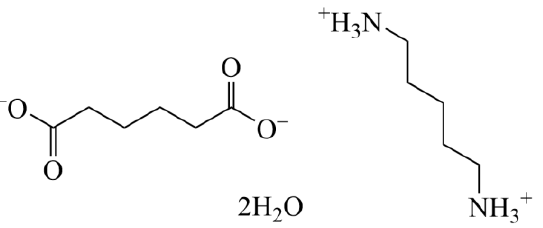
Figure 1. Molecular structure of 1,5-pentanediamine adipate dihydrate.